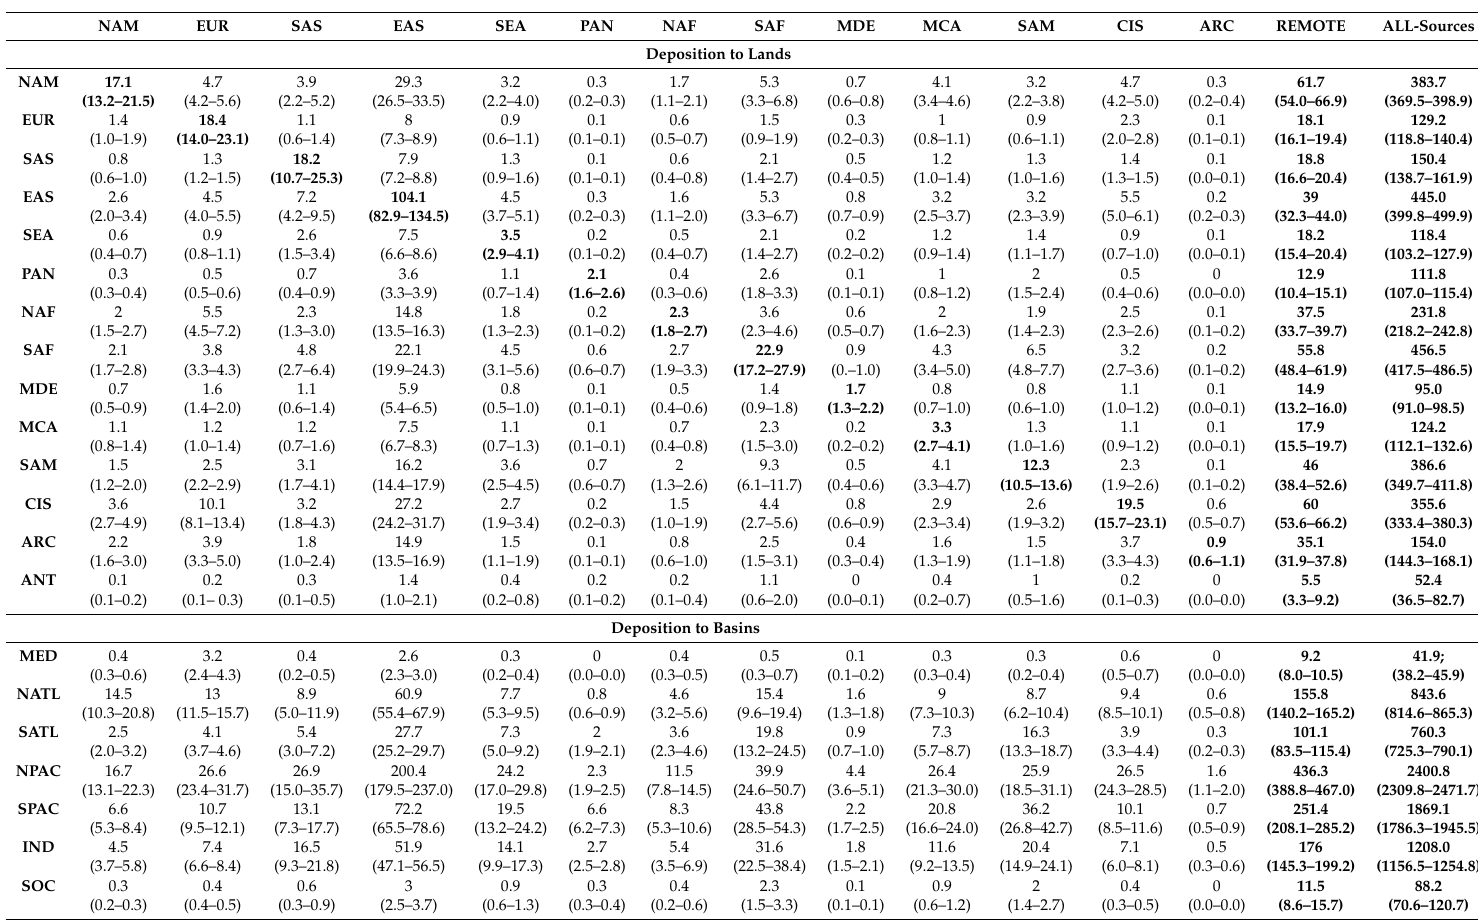
Table 2. Source-receptor Hg deposition uncertainty matrix. For each receptor (rows), the mean (and the relative confidence interval at the 95% level) of the Hg total deposition (Mg/year). The final “All Source” column reports the uncertainty in the total deposition due to all emissions sources, highlighting how the uncertainty in Hg deposition due to domestic emissions is much greater than that for remote sources for almost all source anthr